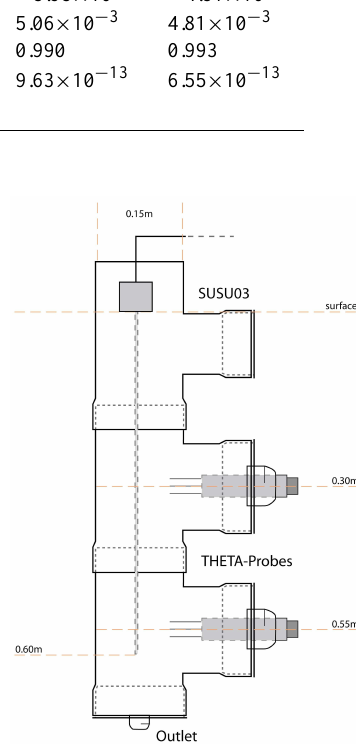
Fig. 5: Sketch of the setup of Experiment 2. A SUSU03 probe and two Theta probes were 3 Fig. 5. Sketch of the setup of experiment 2. A SUSU03 probe and installed in PVC tubes and the tubes were filled with glass beads. At the bottom of the tube, 4 two Theta probes were installed in PVC tubes and the tubes were an outlet permits the controlled and stepwise drainage of water in the tube. 5 filled with glass beads. At the bottom of the tube, an outlet permits the controlled and stepwise drainage of water in the